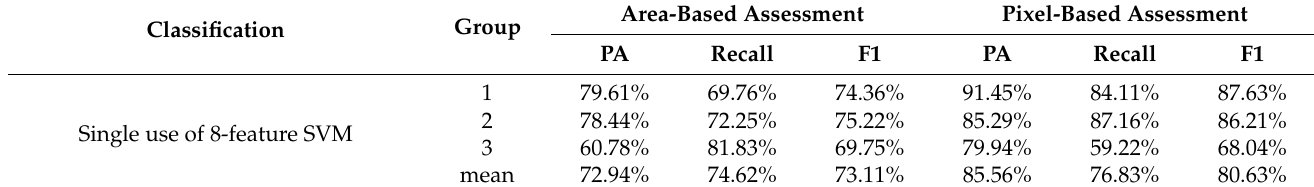
Table 5. Accuracy assessment for 8-feature SVM classifier.